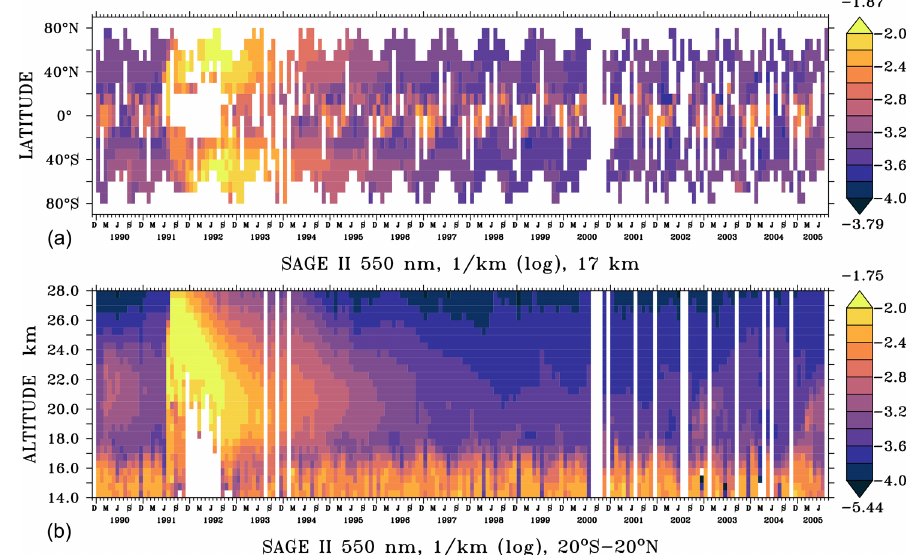
Figure 5. The logarithm of the extinction coefficient (km − 1 ) of the SAGE II instrument from Thomason et al. (2008). The dataset spans the period January 1990–August 2005 (monthly). Horizontal distribution at 16.75km altitude (a) and vertical distribution for tropical regions 20 ◦ S–20 ◦ N (b) . Maximum and minimum values appear above (yellow) and below (dark blue) the colour keys, respectively. White: no